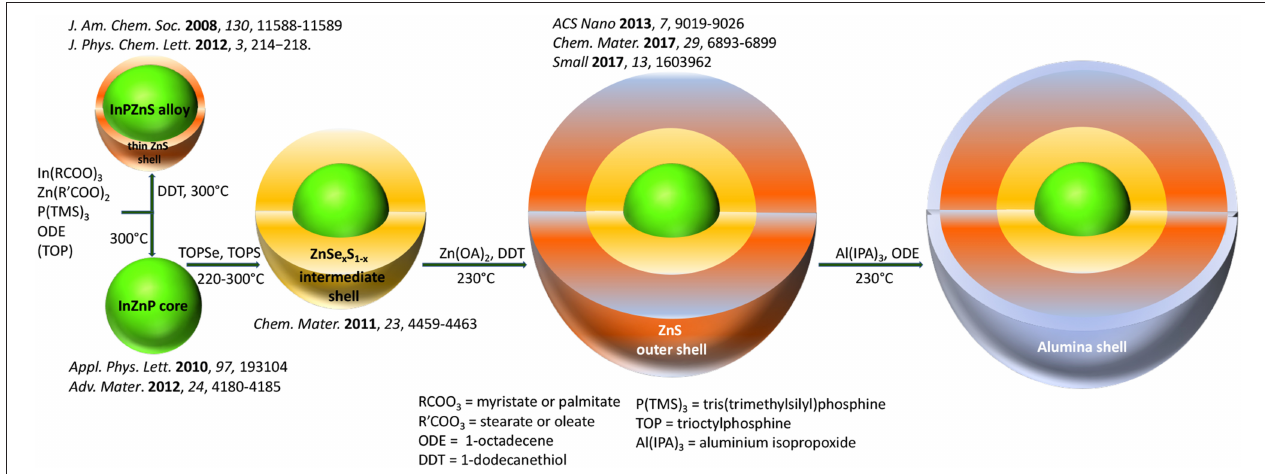
FIGURE 1 | Strategies for the surface passivation of InP-based QDs, leading ultimately to the In(Zn)P/ZnSe x S 1 − x /ZnS core/shell/shell system, illustrated with representative references. The additional surface coating with an alumina shell as described in this work is also displayed in this